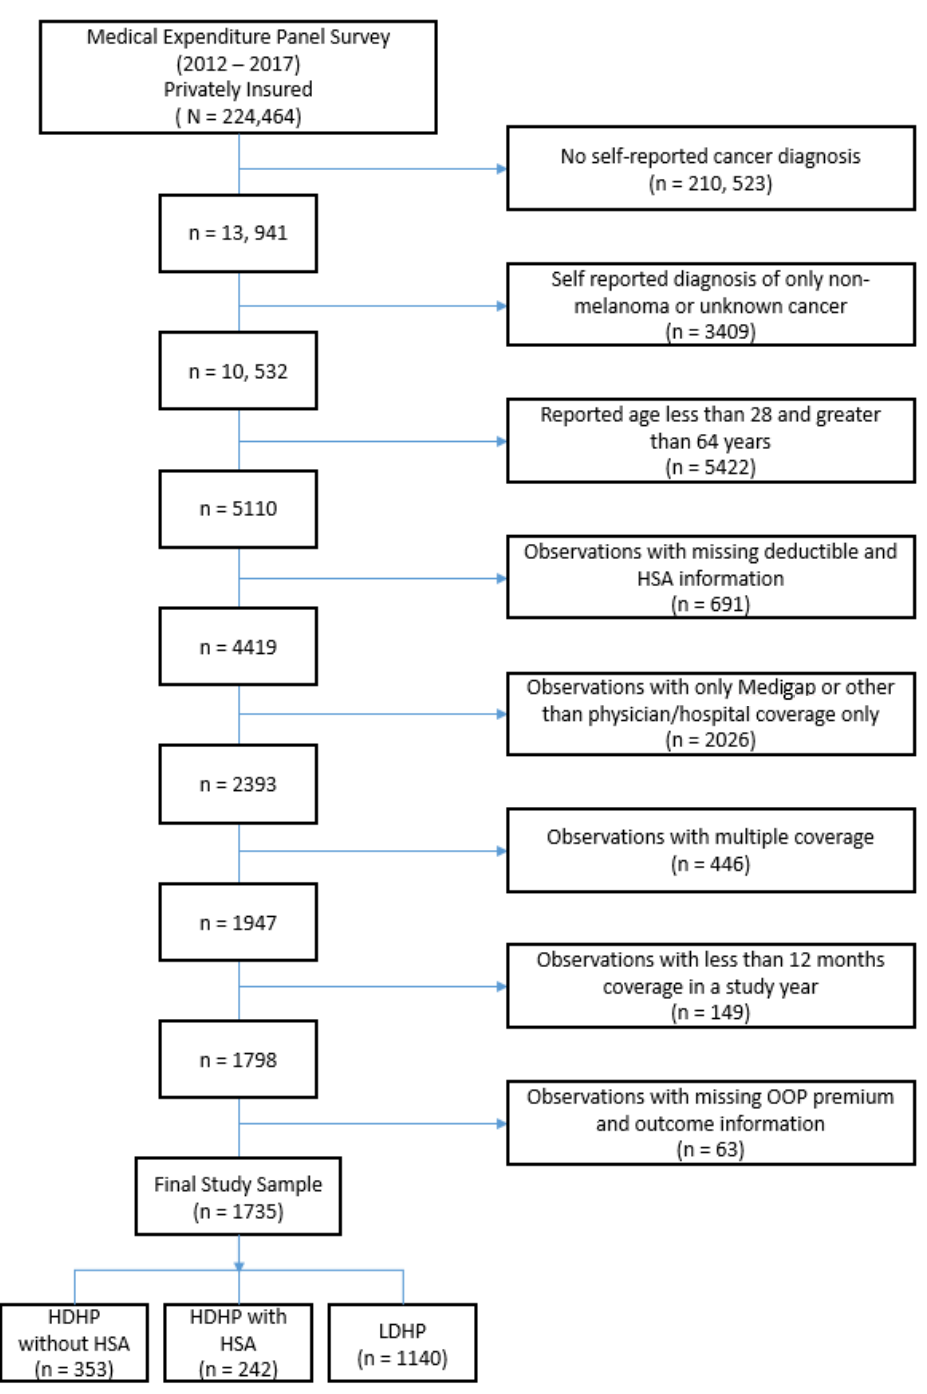
Figure 1. Study sample selection flow